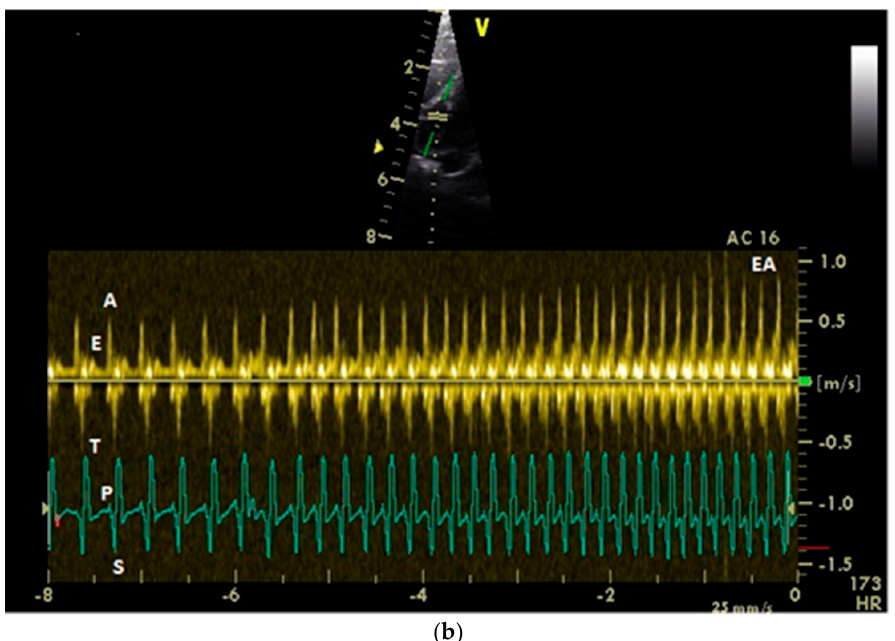
Figure 2. Pulsed-wave Doppler echocardiographic images of a conscious healthy racing pigeon of the left ( a ) and the right ( b ) atrioventricular blood flow depending on heart rate (left a: 166–244; right b: 173–240) using right parasternal approach. Diastolic blood flow: E: early passive ventricular filling; A: active ventricular filling; and EA: fused E and A wave. Electrocardiogram: P: P wave; S: S wave; and T: T wave.